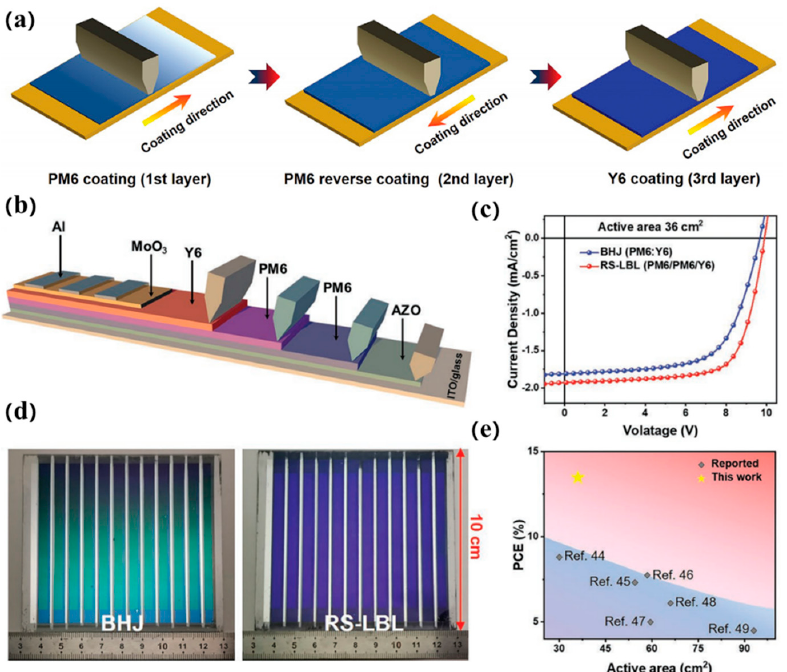
Figure 8. Schematic diagram of ( a ) RS − LBL fabrication. ( b ) Large-area OSC modules. ( c ) The J − V curves of the OSC; ( d ) The photograph of the blade-coated 36 cm 2 OSC modules on a 10 × 10 cm 2 substrate. ( e ) The reported PCEs of binary OSC modules with an active area over 30 cm 2 . Adapted with permission from Ref. [63]. Copyright 2022 Wiley − VCH.